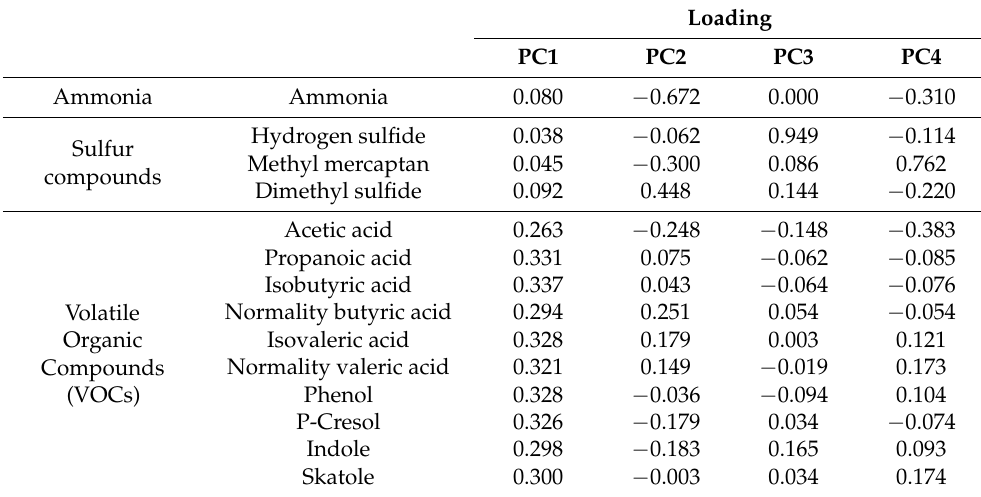
Table 7. Loading values of principal component